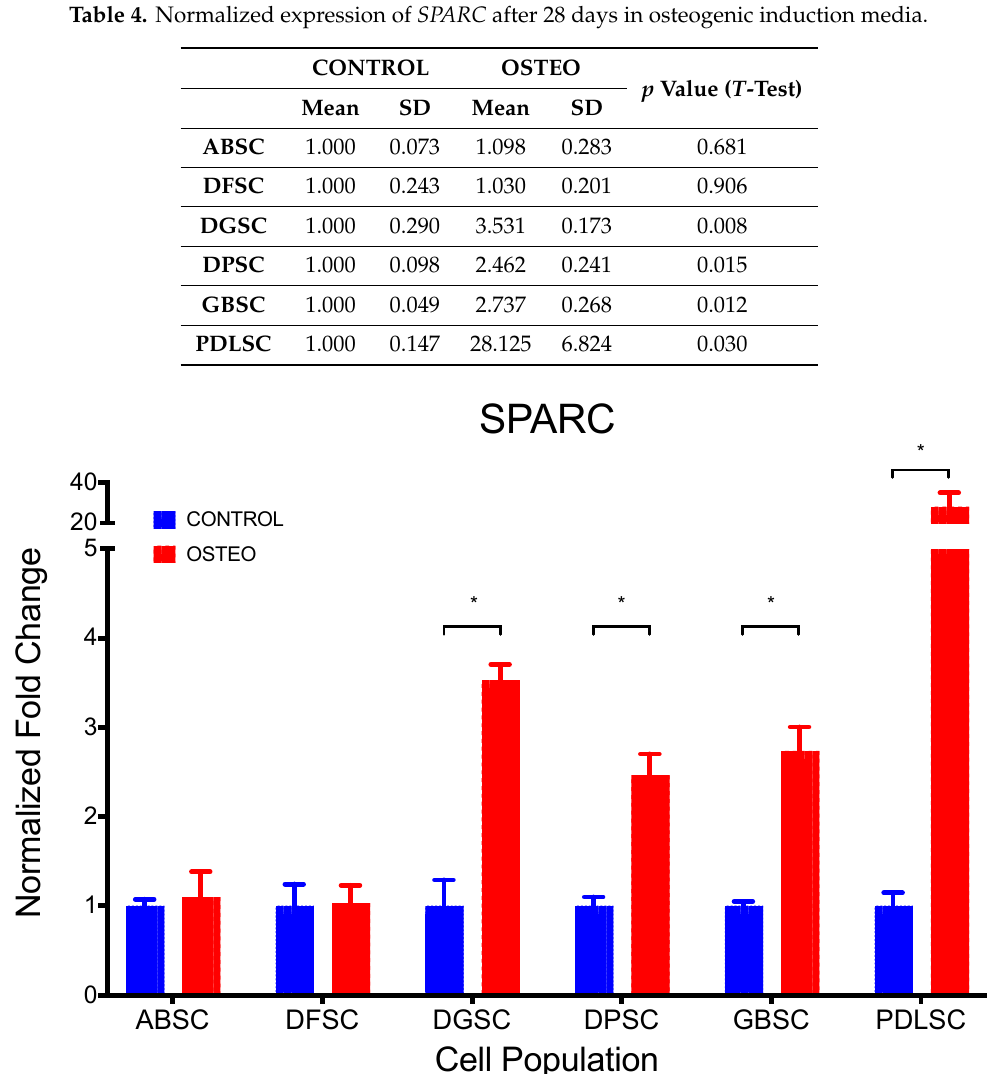
Figure 6. Expression of SPARC (fold change normalized to control) demonstrating a higher and significant detection in cultures induced to osteoblastic differentiation compared to controls ( p < 0.001; t -test), except in ABSC ( p = 0.681) and DFSC ( p = 0.906). Data are shown as mean(SD).